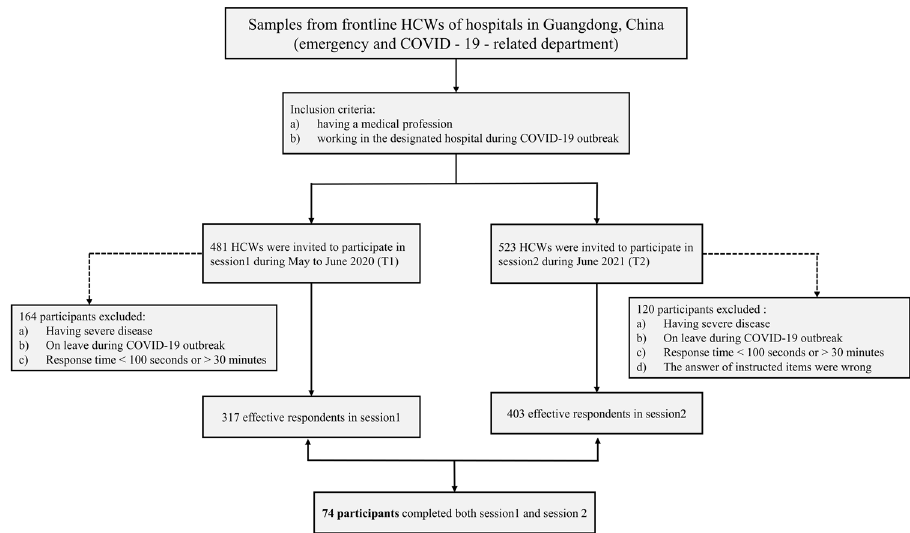
Fig. 1 Sampling frame. Flowchart of the recruitment of frontline